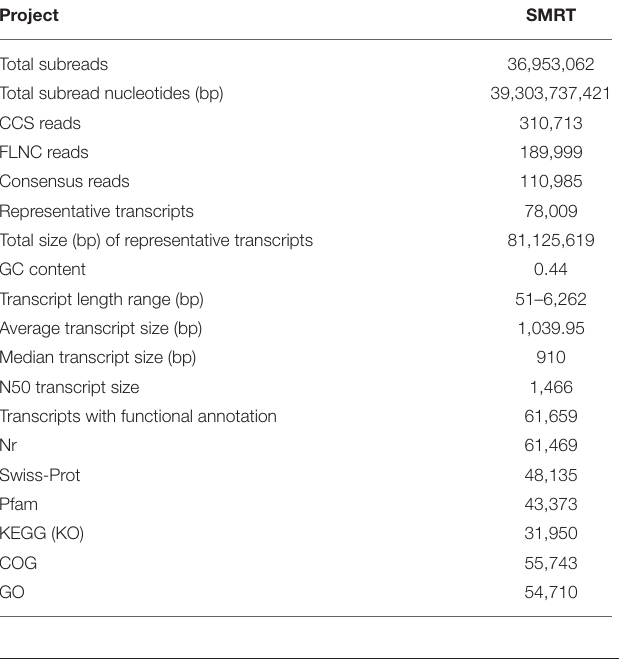
TABLE 1 | Statistics of S. apiana single-molecule real-time (SMRT) sequencing results.